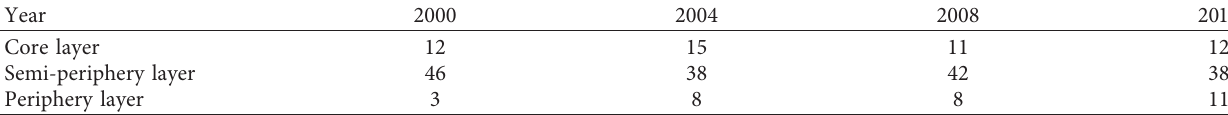
Table 6: Number of core, semi-periphery, and periphery countries, 2000–2012.